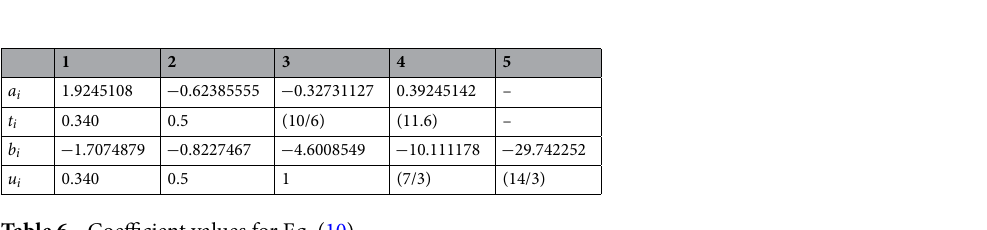
Table 5. The measured mass (g) of CO 2 in the 3.4 liter cylinders, as well as the specific internal energy u (kJ/ kg) collected from the NIST webbook 54 .